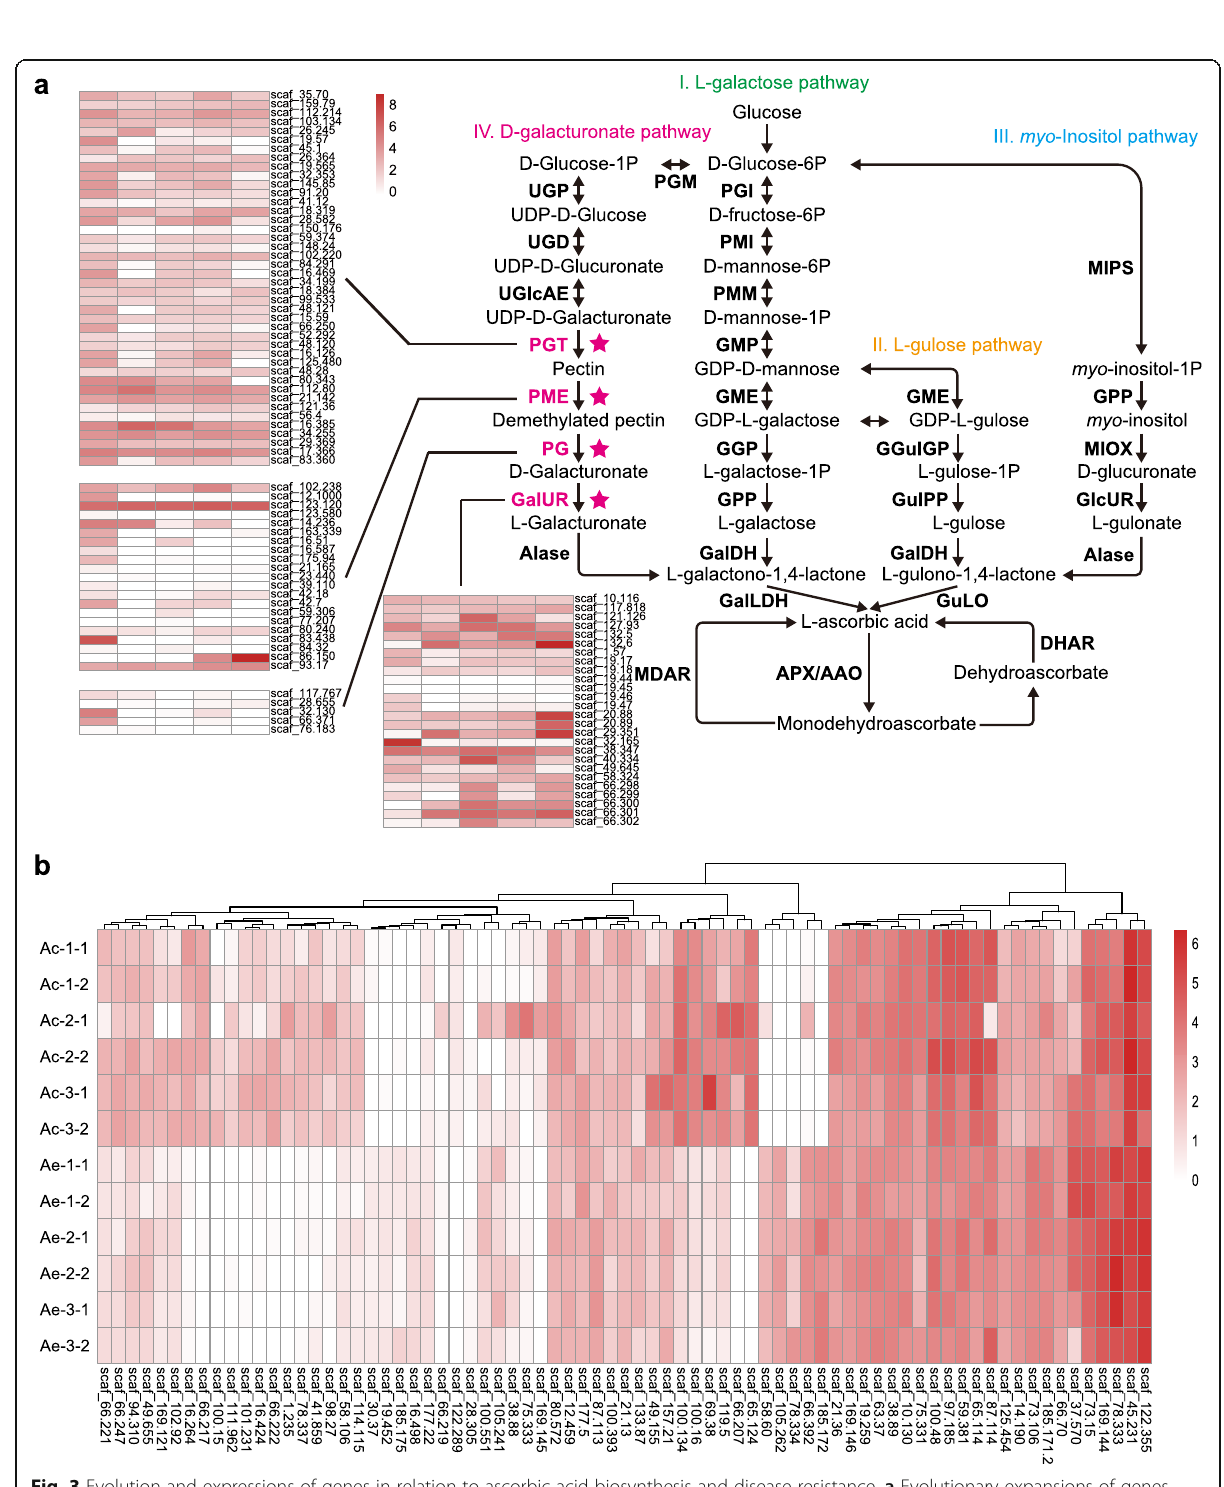
Fig. 3 Evolution and expressions of genes in relation to ascorbic acid biosynthesis and disease resistance. a Evolutionary expansions of genes involved in the D-galacturonate pathway of ascorbic acid biosynthesis. Expressions of these genes in five different tissues (from left to right: fruit, flower, leaf, stem and root) were revealed. b Differential expressions of the common R genes between Ae and Ac. A previously available RNA-seq data was used and two sampling repeats in each of the three stages of Psa infection are